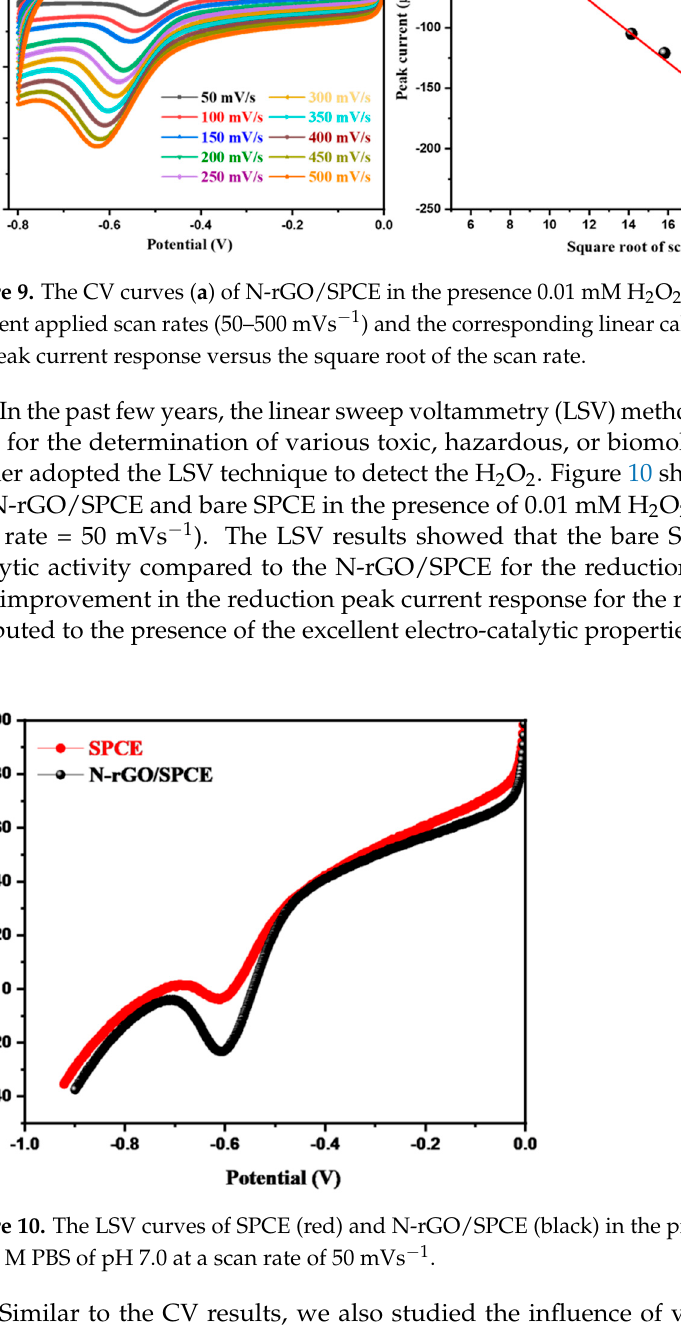
Figure 11. The LSV curves ( a ) of N-rGO/SPCE in the presence of different concentrations of H 2 O 2 (0.01, 0.05, 0.1, 0.2, 0.3, 0.4, 0.5, 0.6, 0.8, and 1.0 mM) in 0.1 M PBS of pH 7.0 at a scan rate of 50 mVs − 1 and the corresponding linear calibration plot ( b ) between the peak current response versus the concentration of H 2 O 2 . Furthermore, we also recorded 50 consecutive LSV curves of N-rGO/SPCE in the presence of 0.05 mM H 2 O 2 at the applied scan rate of 50 mVs − 1 . The 1 st , 25 th , and 50 th LSV curves of the N-rGO/SPCE are presented in Figure 12.